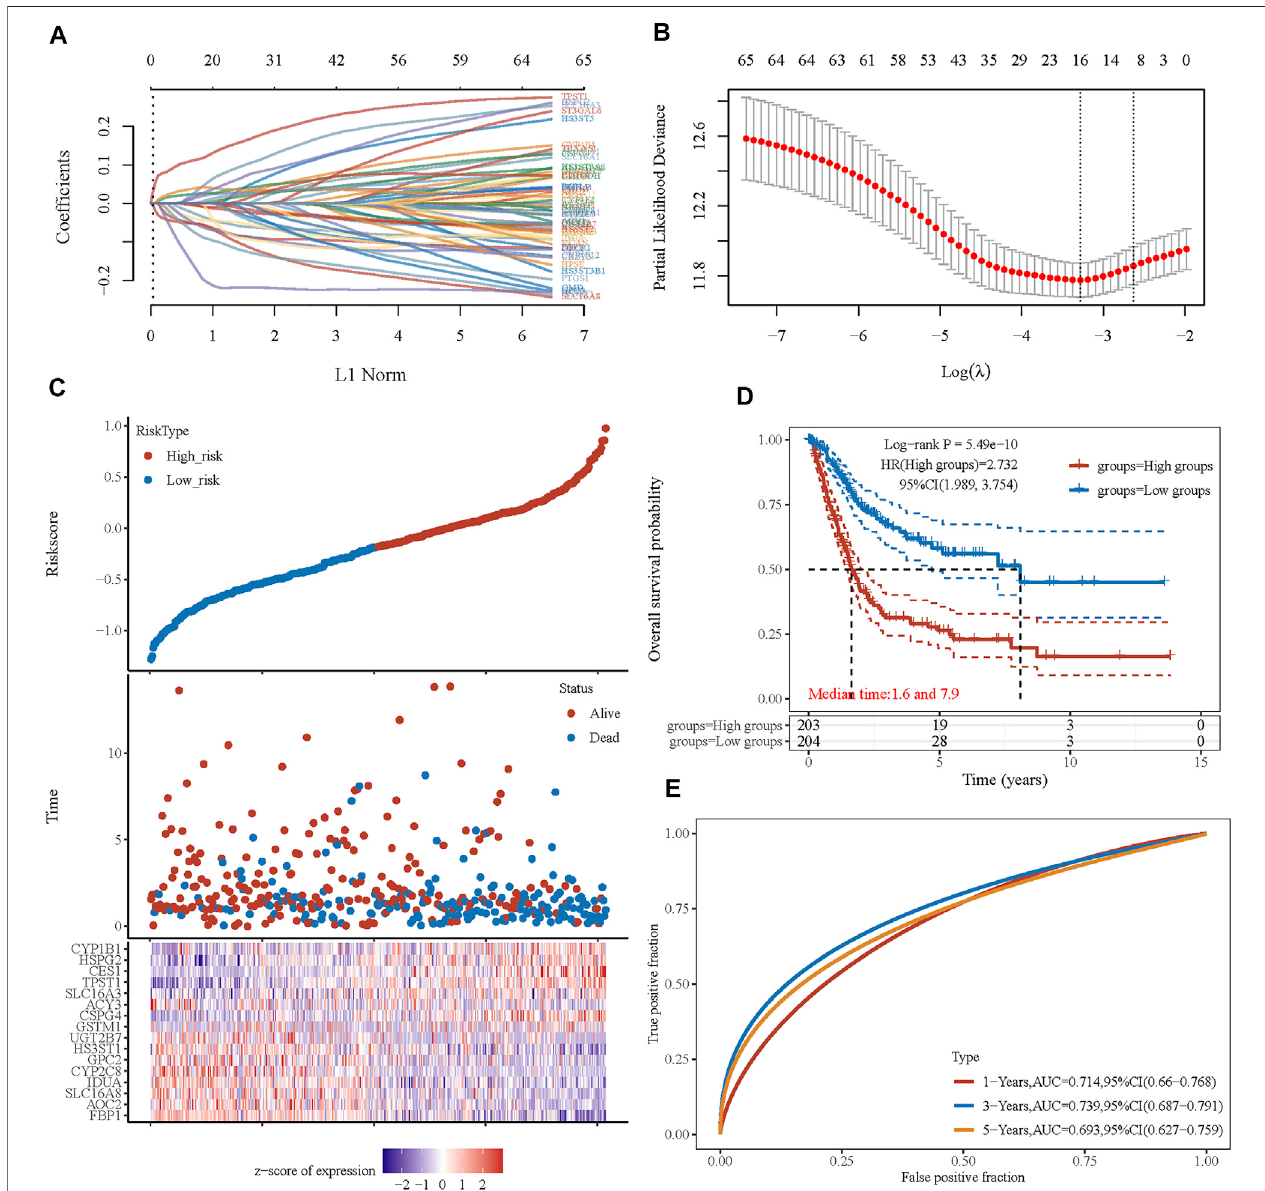
FIGURE 5 | Prognostic signature was established based on four prognostic energy metabolism-related genes. (A) LASSO coef fi cient pro fi les of the genes associated with the metabolism of BLCA. (B) Partial likelihood deviance is plotted versus log( λ ). (C) The risk score of each sample based on the energy metabolism- related gene set. Patients were divided into low-risk and high-risk groups according to the median value of the risk score. The high/low expression levels of 16 genes which were involved in the prognostic signature are shown in red/blue in each sample. (D) The Kaplan – Meier curve of overall survival differences strati fi ed by signature riskscore. (E) The ROCcurves ofthe signature for overallsurvival at 1,3, and 5 years. LASSO:least absolute shrinkage and selection operator. ROC:receiver operating characteristic.